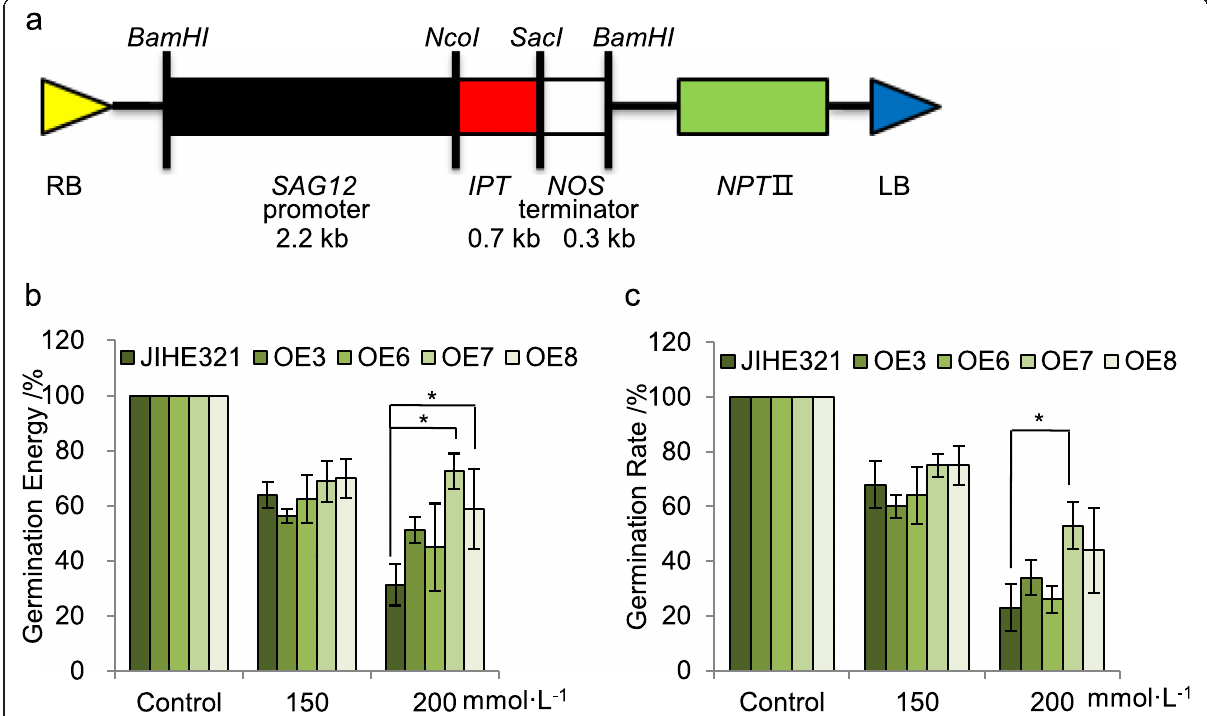
Fig. 1 Ectopic-expression of SAG12::IPT promotes cotton seed germination. a Schematic diagram of the SAG12::IPT fragment fused in pSG529 vector. The yellow triangle indicates right boundary (RB). The black rectangle indicates 2.2 kb of Arabidopsis SAG12 promoter fused with Bam HI and Nco I. The red rectangle indicates 0.7 kb of Agrobacterium tumefaciens IPT gene fused with Nco I and Sac I. The white triangle indicates 0.3 kb of NOS terminator fused with Sac I and Bam HI. The green triangle indicates NTP II gene generating kanamycin resistance. The blue triangle indicates left boundary (LB). b Ectopic expression of SAG12::IPT promotes cotton seed germination energy. Twenty seeds of each transgenic cotton line were treated with or without 150 and 200 mmol·L − 1 NaCl for 24 h. The germination energy was measured after 3 days NaCl treatment. c